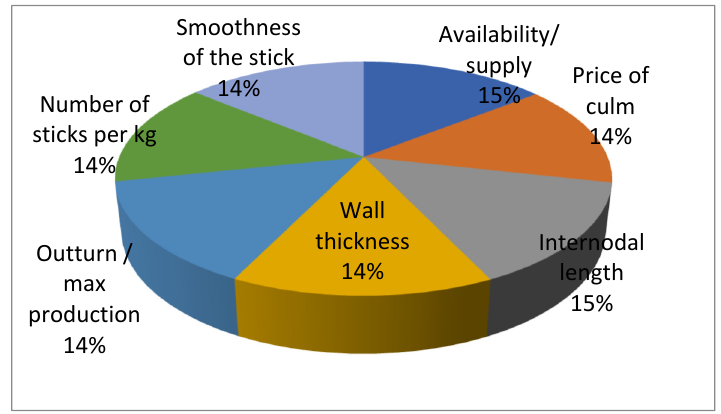
Figure 1. Percent contribution of different attributes for the choice of species for the incense stick industry.